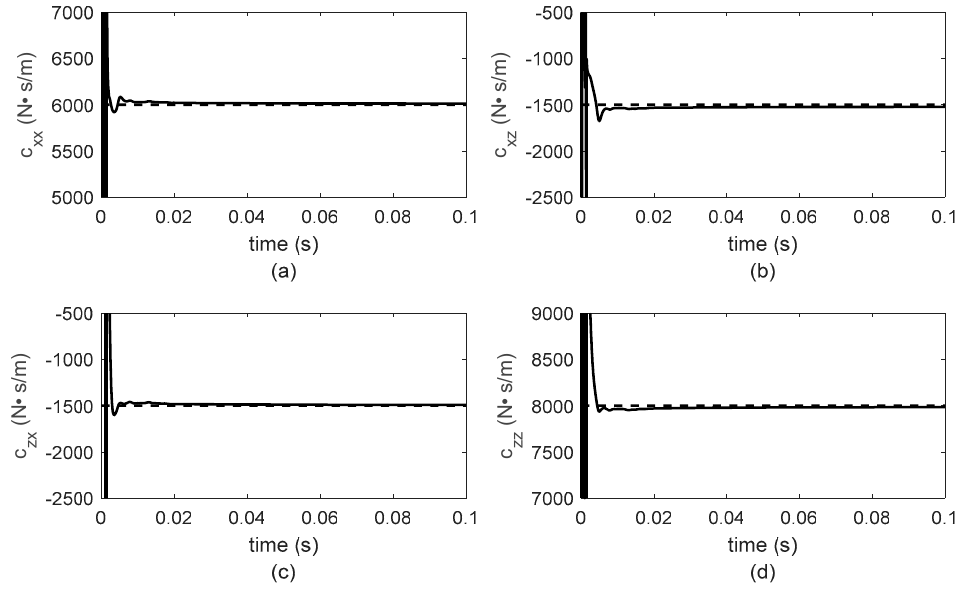
Figure 8. Identified damping parameters for bearing 2 at 600 rpm. ( a ) (cid:1855) (cid:3051)(cid:3051) , ( b ) (cid:1855) (cid:3051)(cid:3053) , ( c ) (cid:1855) (cid:3053)(cid:3051) , ( d ) (cid:1855) (cid:3053)(cid:3053) .